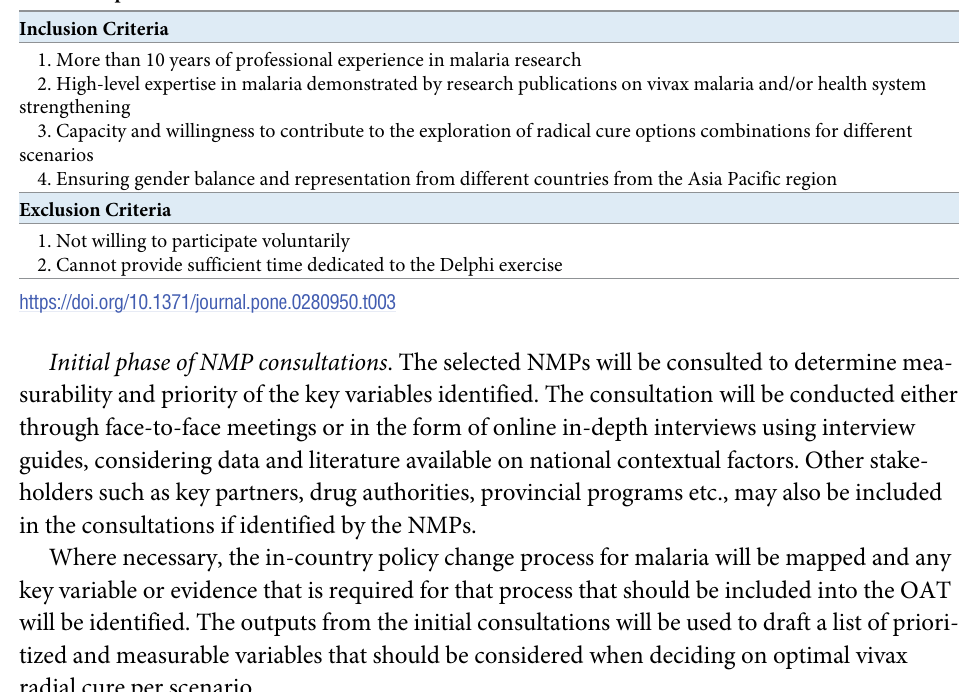
Table 3. Expert selection criteria.